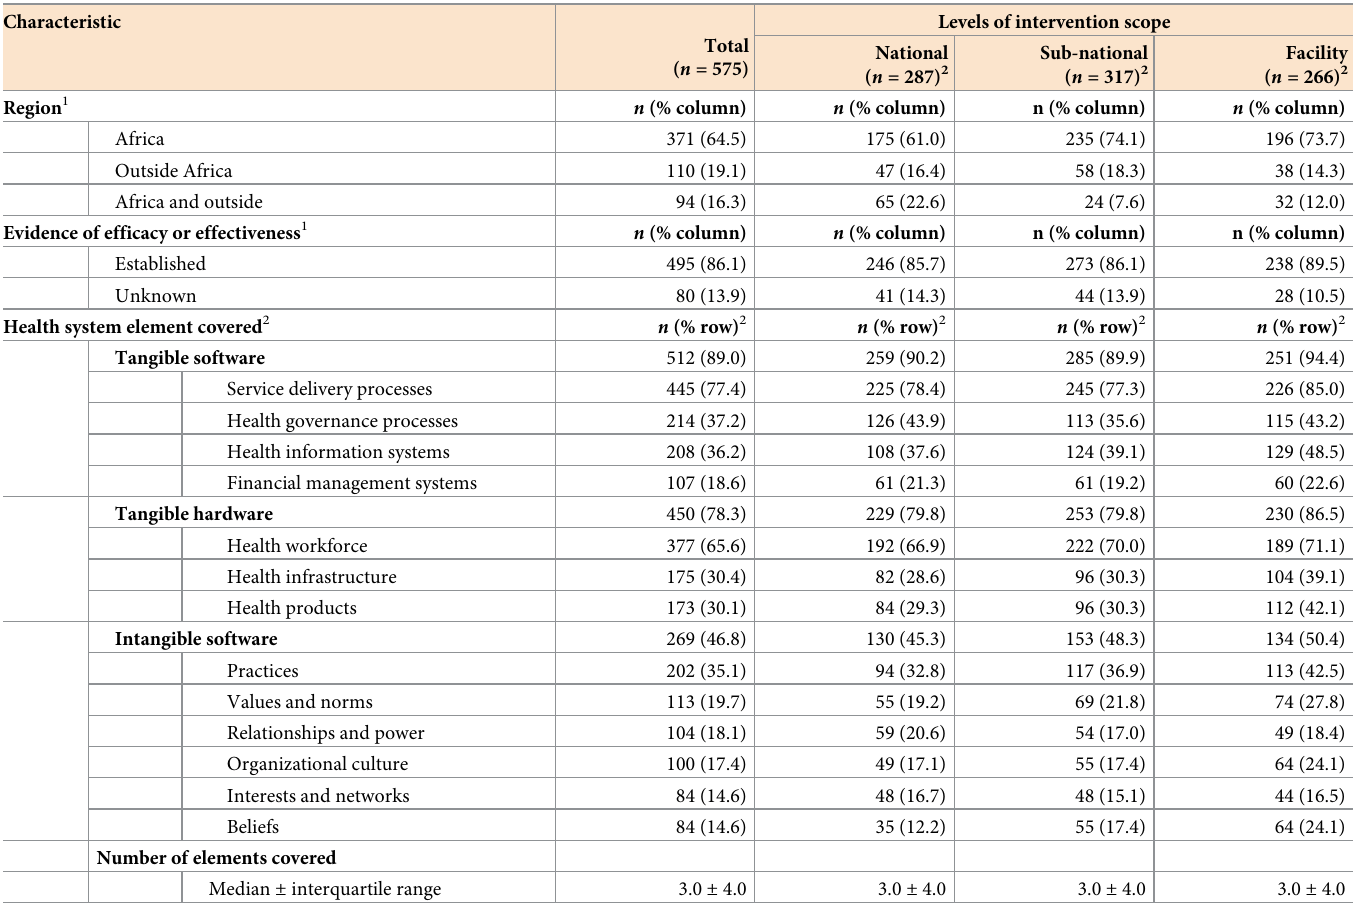
Table 2. Characteristics of included